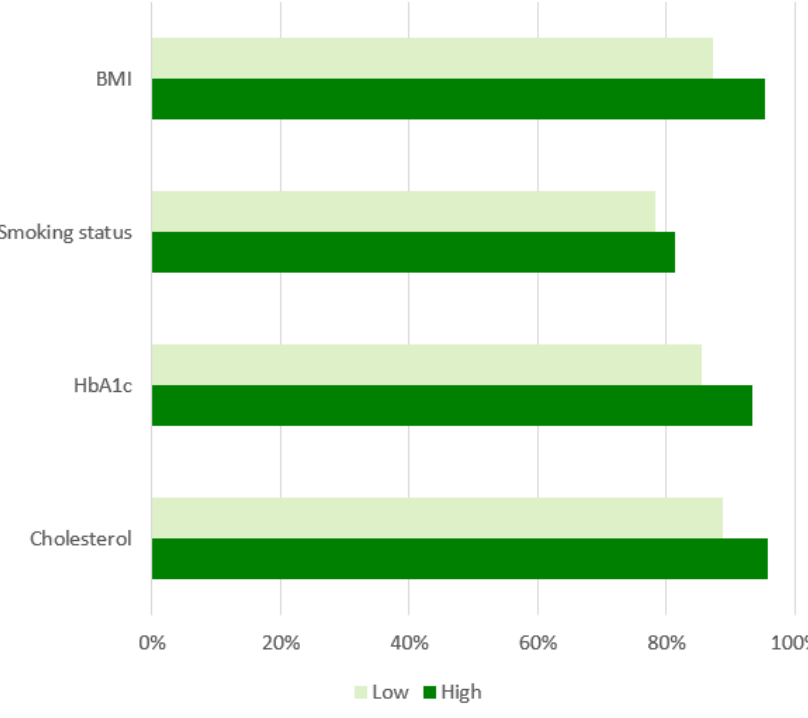
Figure 5. Differences of bioclinical follow-up quality between low-to-moderate and moderate-to-high health care services consumption of patients with diabetes in 2016. HbA1c: glycated hemoglobin.